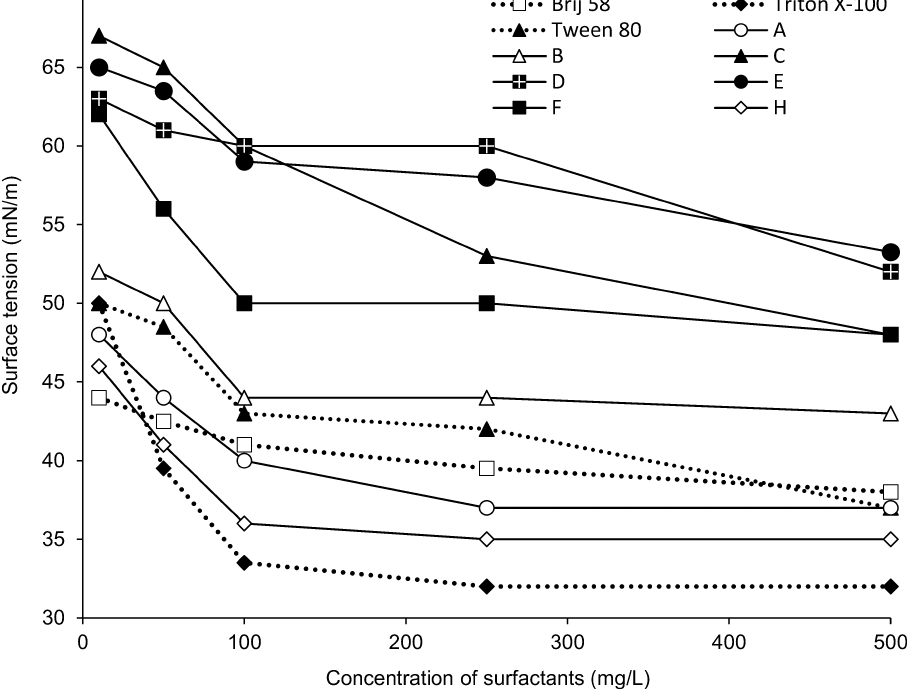
Figure 1. Surface tension (mN/m) as a function of surfactant concentrations (mg/L).